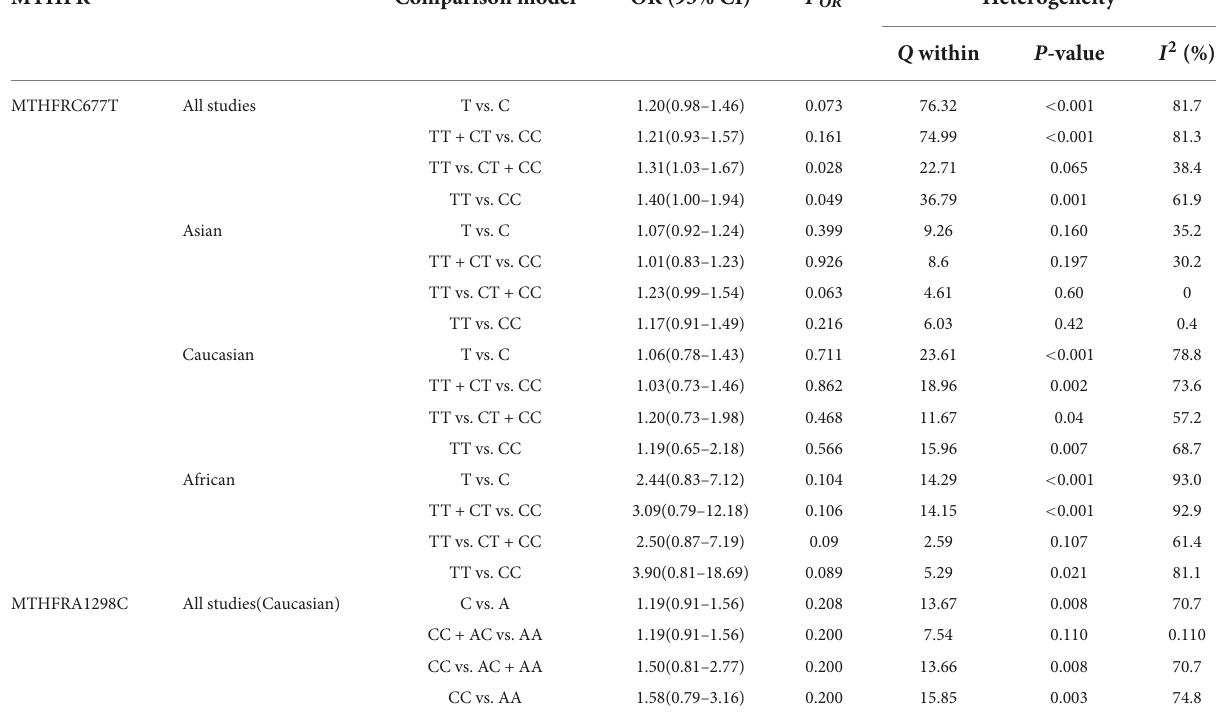
TABLE 5 Odds ratios and heterogeneity results for the 4 genetic models of the MTHFR C677T and A1298C for BPD.